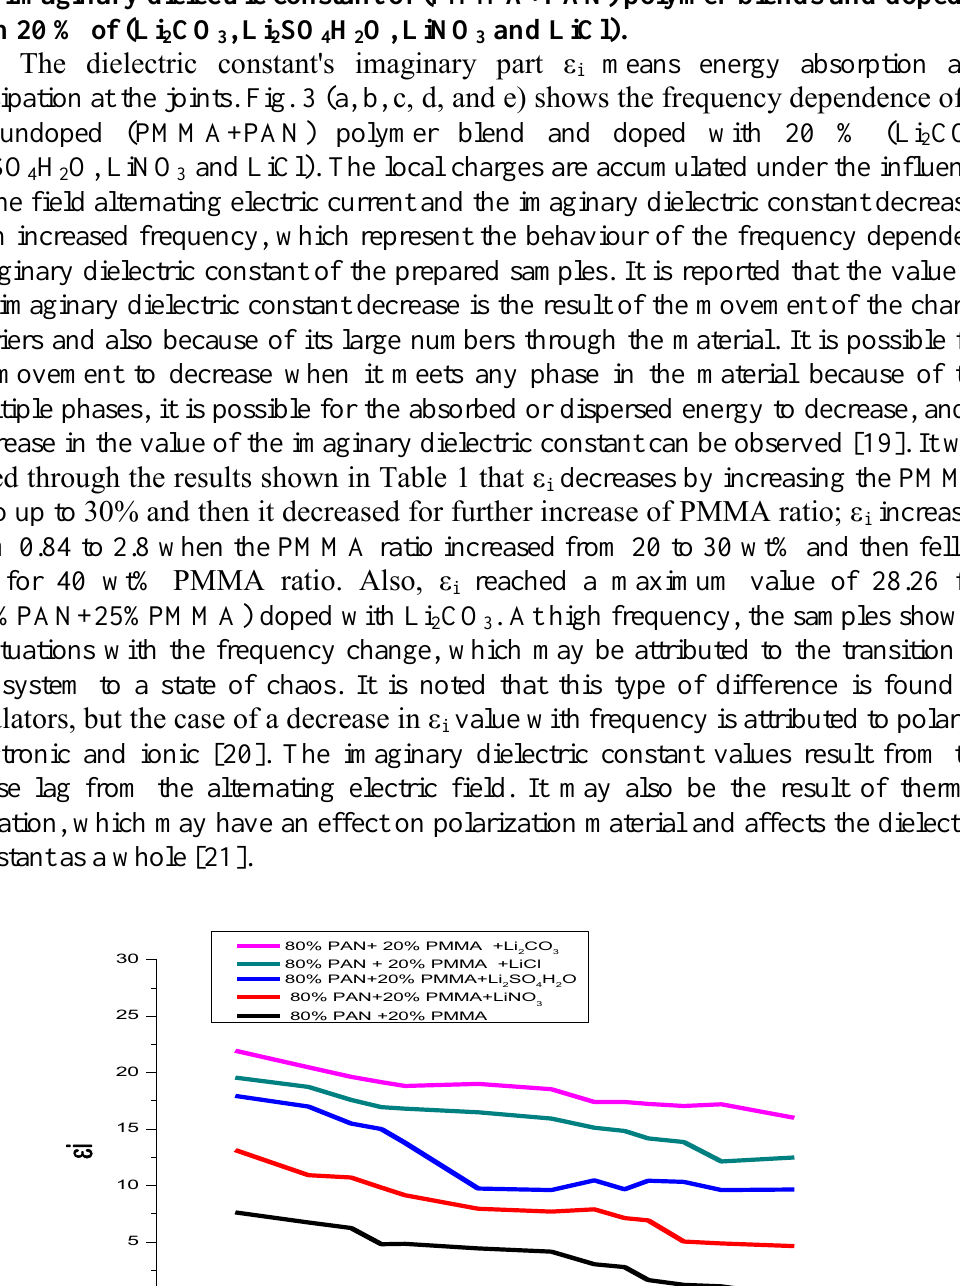
, LiCl, Li CO , and Li SO H 3 2 3 2 4 2